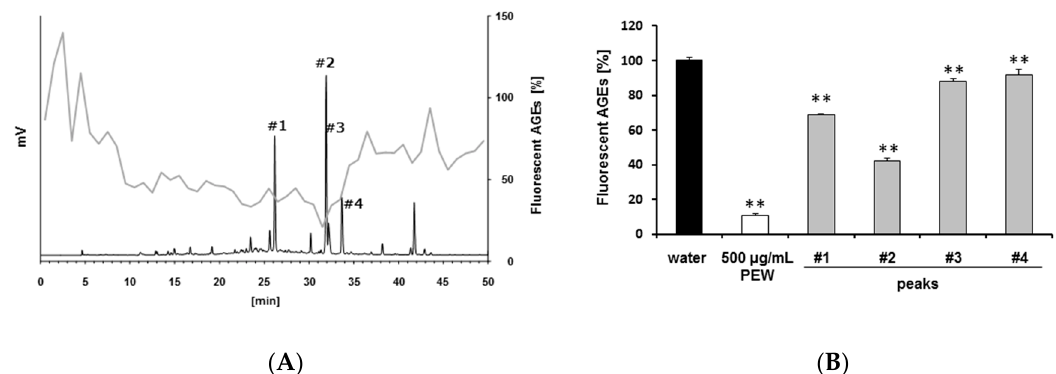
Figure 2. Isolation of antiglycative compounds in Persicaria hydropiper . PEW was fractionated using high-performance liquid chromatography ultraviolet (HPLC-UV). Fractions were collected every minute. ( A ) Black line: HPLC chromatogram at 270 nm. Gray line: the efficacy of fractionated samples against formation of fluorescent AGEs. ( B ) Two-hundred microliters of 5 mg/mL solid-content concentration of PEW was used to isolate these four peaks and was concentrated to around 50 μ L by using a rotary evaporator. Then, each solution was adjusted to 200 μ L by water. To compare the effect of individual peaks with the whole PEW efficacy, 5 mg/mL solid content of PEW was also used. The whole PEW and the indicated isolated peaks were added as 10% volume content to the HSA glycation